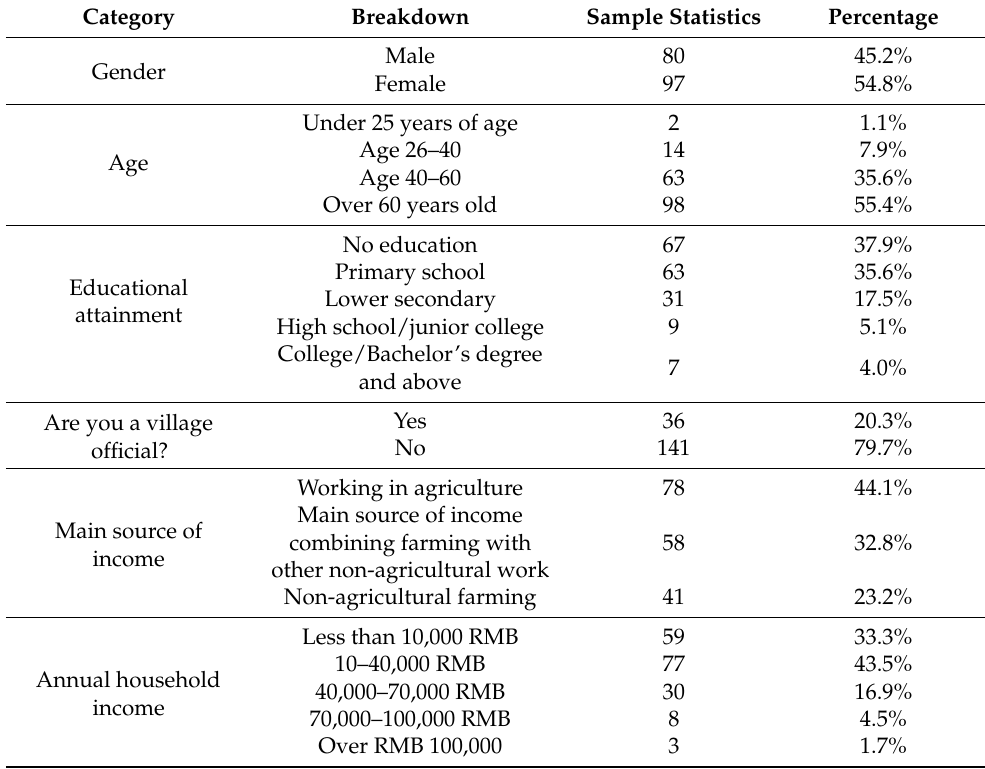
Table 2. Statistics of basic information of